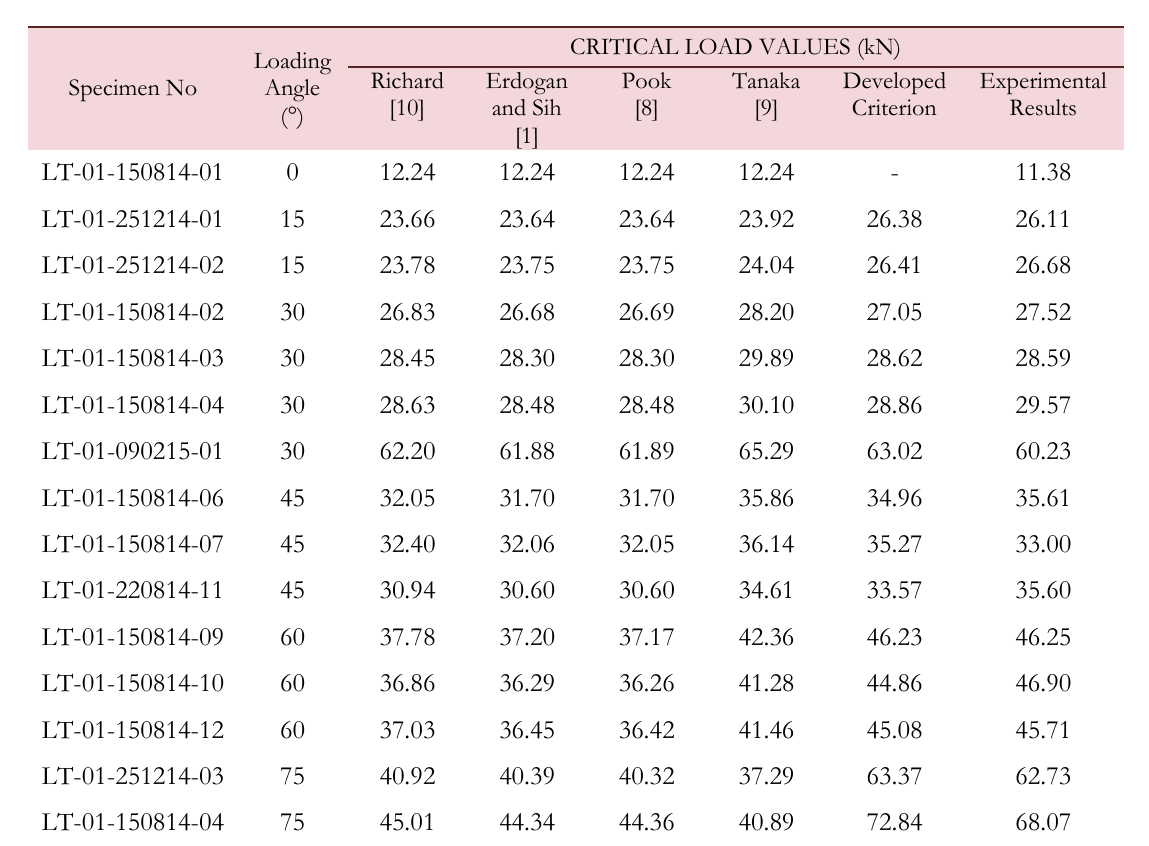
Table 4: Experimental and predicted CTS specimen fracture load values obtained from the developed criterion with other existing criteria in the literature.